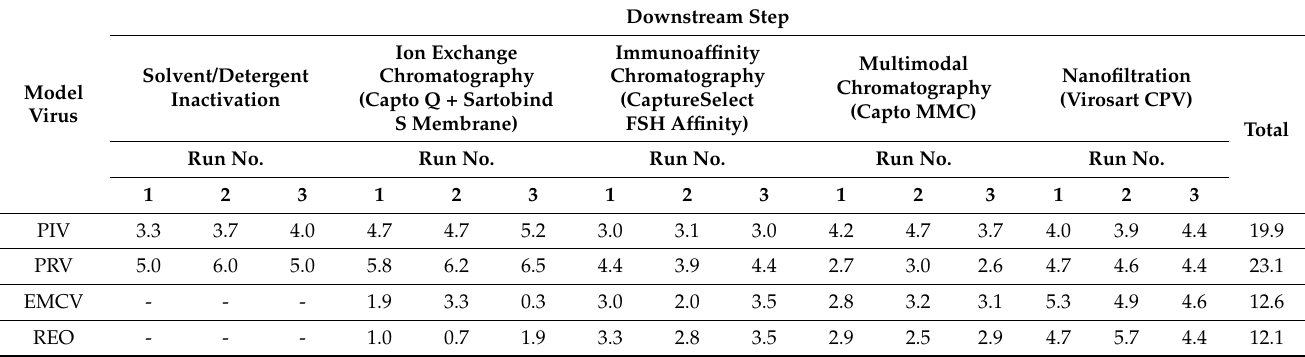
Table 3. Reduction factor (RF) for model viruses pseudorabies virus (PRV), parainfluenza virus (PIV), reovirus type-3 (REO), and encephalomyocarditis virus (EMC) in five downstream steps of r-hFSH.